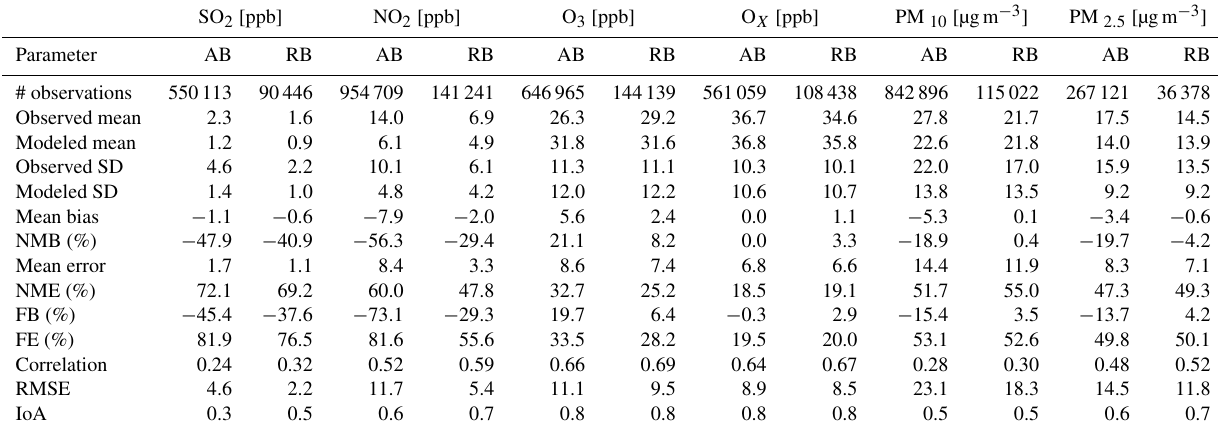
Table 2. CAMx model performance metrics at all (AB) and rural (RB) background AirBase sites. Metrics are computed for daily mean concentrations for the calendar year